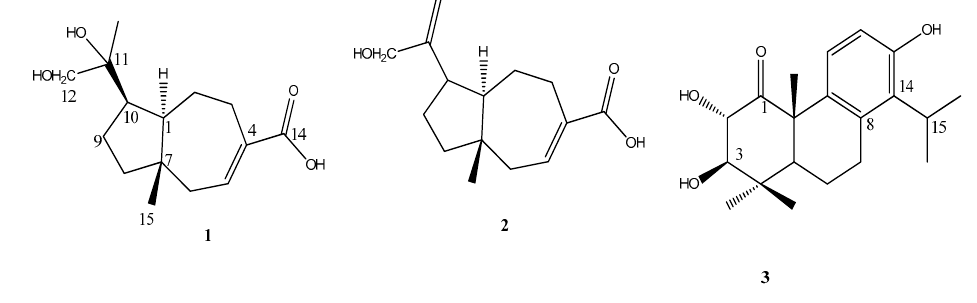
Figure 1. Structures of compounds 1 – 3 .